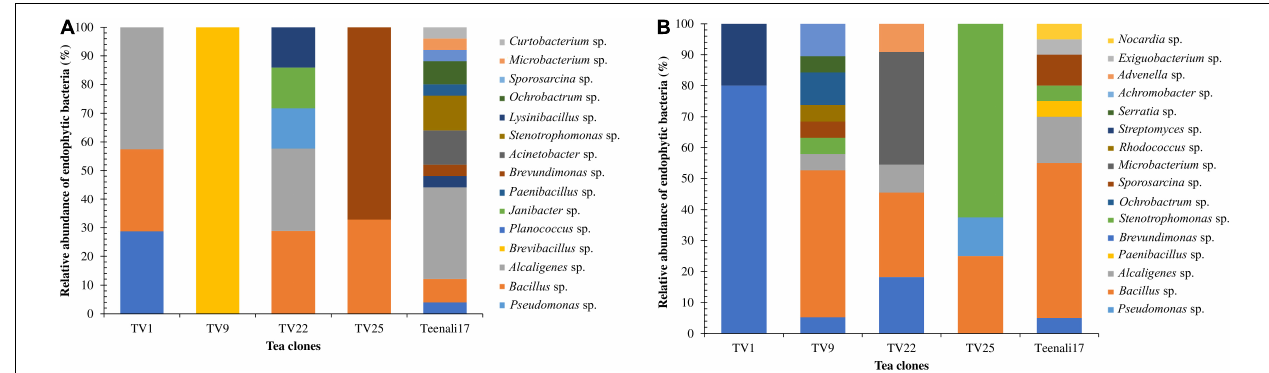
FIGURE 1 | Relative abundance (in percentage) of endophytic bacterial genera procured from (A) leaf and (B) roots of five different tea clones (TV1, TV9, TV22, TV25, and Teenali 17).